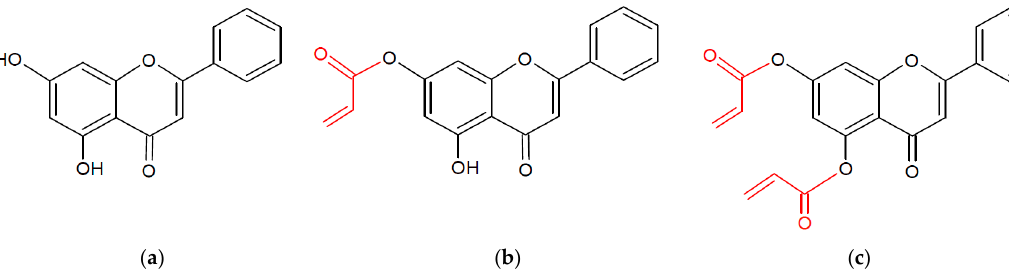
Figure 1. HPLC chromatograms for Chrysin and chrysin multiacrylate (ChryMA).